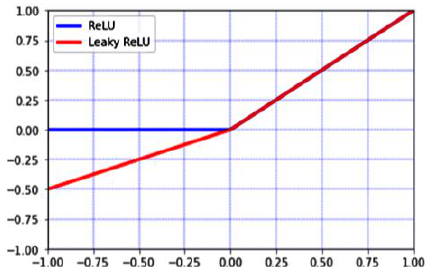
Figure 3. Comparison of the ReLU and Leaky ReLU functions .